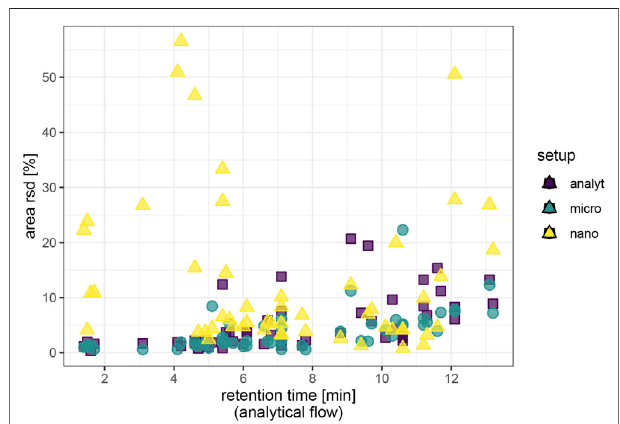
FIGURE2| Repeatabilityofsignalintensitybasedonrepeatedinjections (N = 4) of spiked plasma extract. Endogenous metabolites and caffeine/ caffeine metabolites were assessed at natural abundance; ceftiofur and coumaphosat 10 μ g/L,all otherexogenouscompounds at1 μ g/L. Area values are background